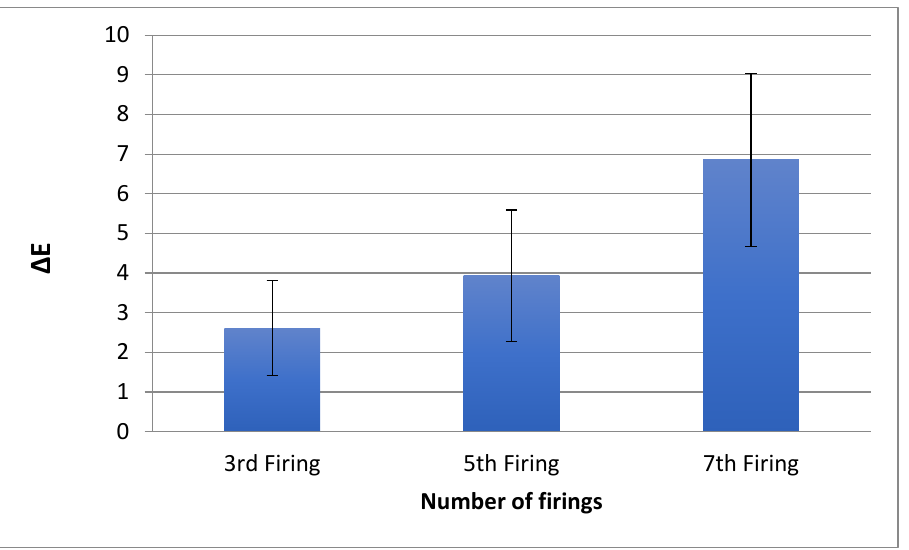
Figure 1. ΔE comparison of samples after the third, fifth, and seventh firing s. Figure 1. ∆ E comparison of samples after the third, fifth, and seventh firings.